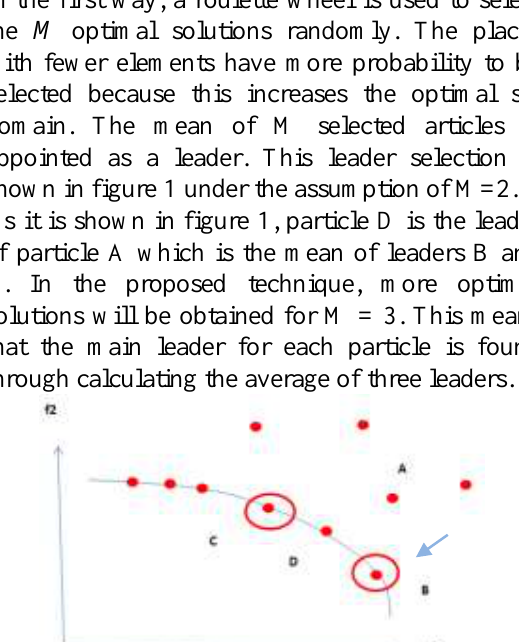
Figure 1. Leader selection (1 st approach).